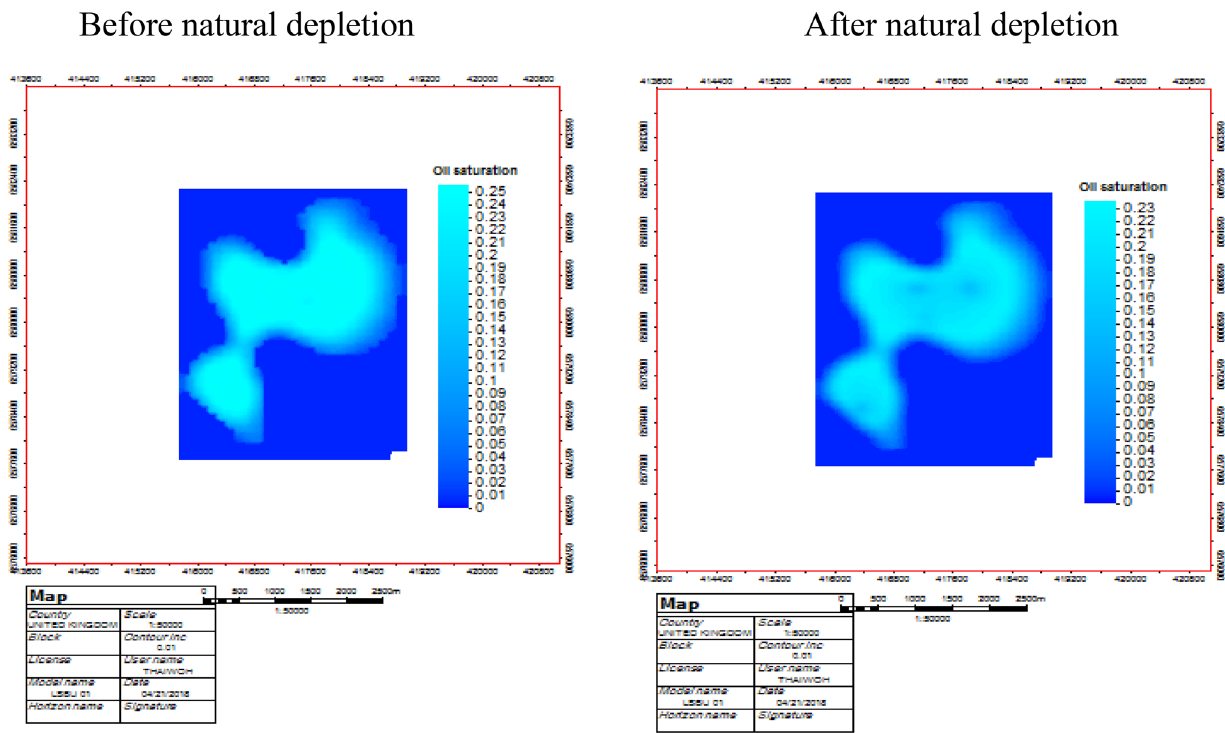
Fig. 10 Area map showing area sweep